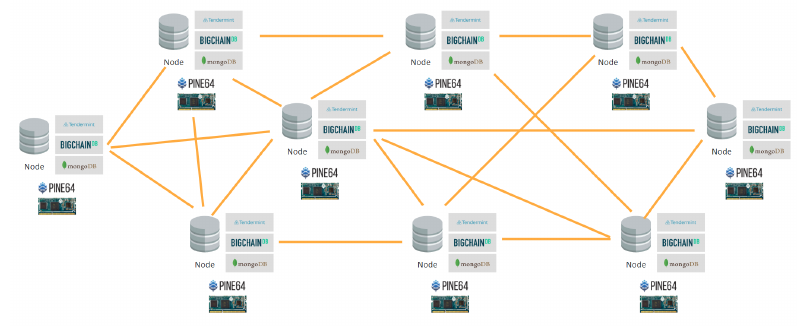
Fig. 4. Network structure to enable inter-agent